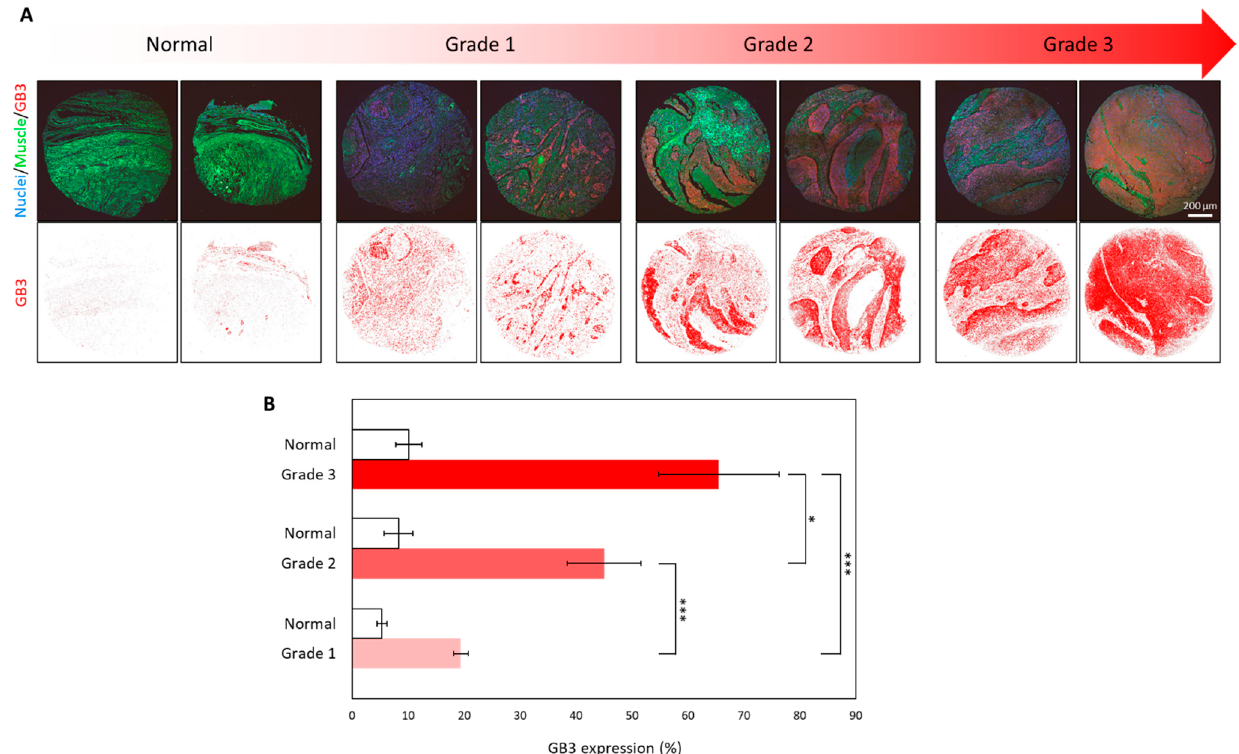
Figure 3. GB3 expression in sections of paraffin-embedded biopsy samples. Confocal microscopy images of tissue samples from patients displaying different clinical grades of HNSCC. ( A ) Top panels: Multichannel confocal microscopy images on tissues immunostained with Alexa647-anti-CD77 (red-channel). Nuclei were stained with Dapi (blue-channel), and tissue autofluorescence appears in the green channel. GB3 immunohistochemistry appears in the red channel. Normal controls and the different anatomopathological grades of HNC malignancy are indicated. The bottom panel shows the GB3 signal digitally extracted from the confocal images. The red color in the images corresponds to the GB3 immunostaining signals detected. Scale bars = 200 μ m. ( B ) Quantitative examination of GB3 expression ( n = 33, p = 0, 6.3 × 10 − 7 and 0.019 comparing grade 1 to grade 2, grade 1 to grade 3 and grade 2 to grade 3, respectively; *** p < 0.001 and * p < 0.010).